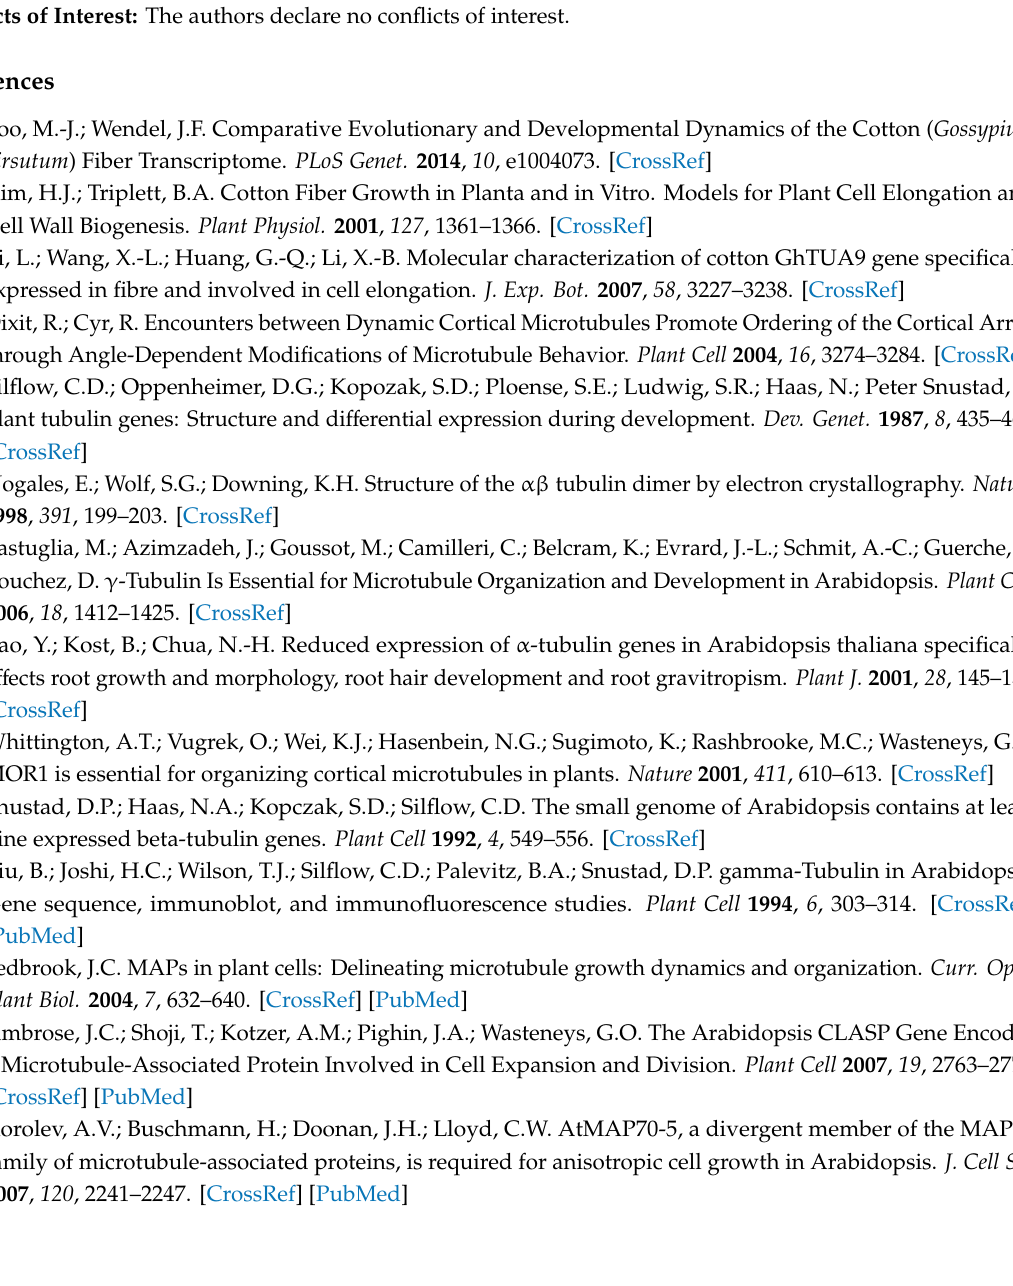
Table S1: Chromosomal locus ID, length and pI of TPX2 proteins in cotton; Table S2: Selective pressure of homologous genes among G. arboreum , G. raimondii and G. hirsutum , and segmental duplication of these genes; Table S3: The FPKM value of TPX2 genes in di ff erent cotton tissues (root, stem, leaf, flower, ovule, and fiber) and various fiber developments in cotton fiber (69307 and 69362). The FPKM value of Tubulin genes of fiber development in cotton fiber (69307 and 69362). Table S4: List of the primers used for quantitative real-time PCR in this study. Additional File 1: 170 TPX2 protein sequences from seven